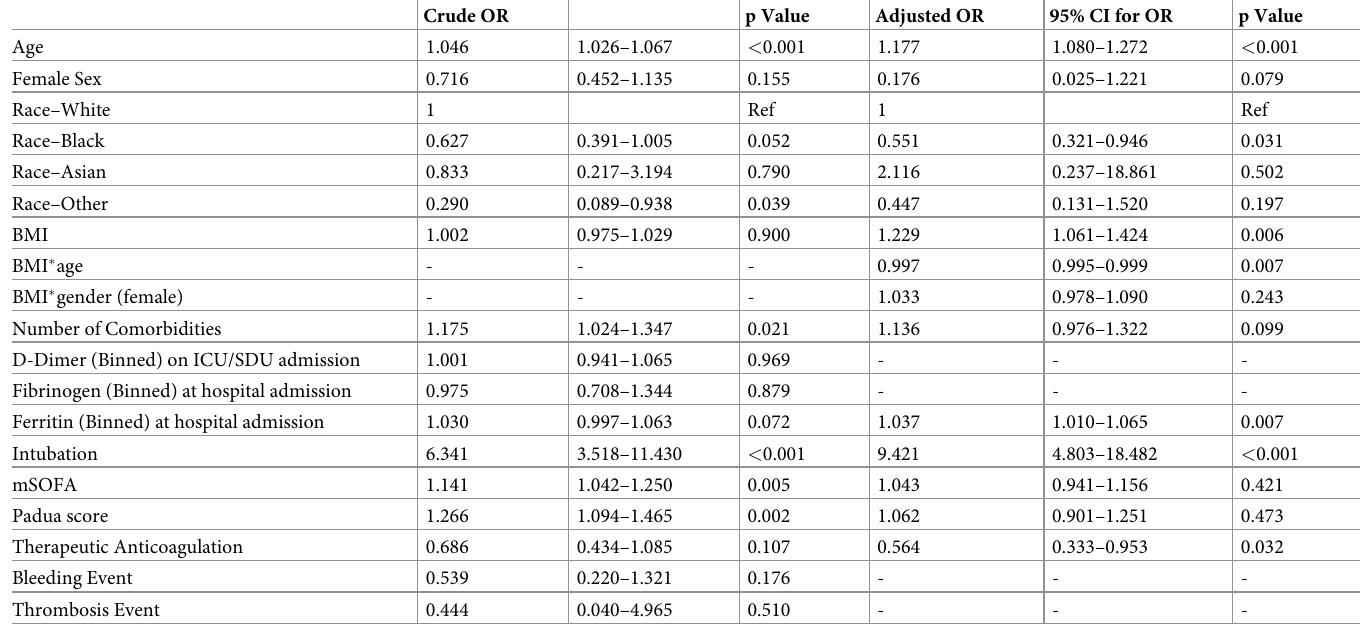
Table 2. Unadjusted and adjusted parameter estimates of weighted generalized equation estimation to predict inpatient mortality. Crude OR p